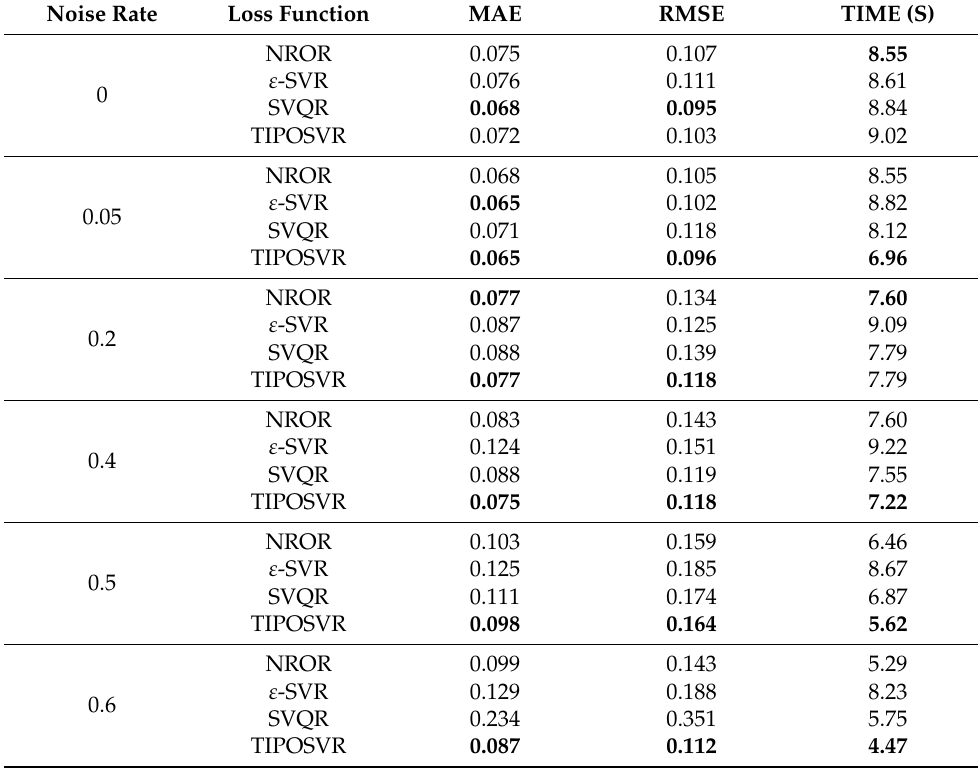
Table 5. Operation results of algorithms under the influence of noise type III for synthetic dataset.